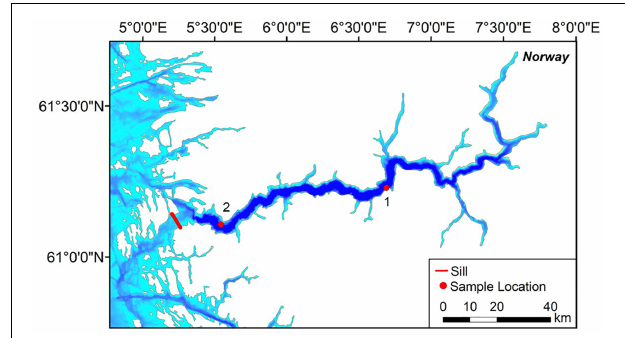
FIGURE 1 | Location of the two AEgir 6000 transects in Sognefjord, Norway. Digital bathymetry with a resolution of 1/16 × 1/16 arc min was extracted from EMODnet Bathymetry Consortium (2018). ArcGIS (version 10.4; Environmental Systems Research Institute [ESRI], 2016) was used to map the